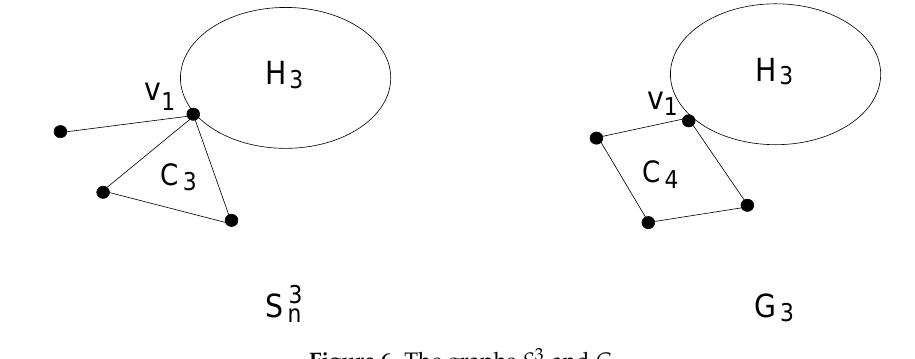
Figure 6. The graphs S 3 n and G 3 .